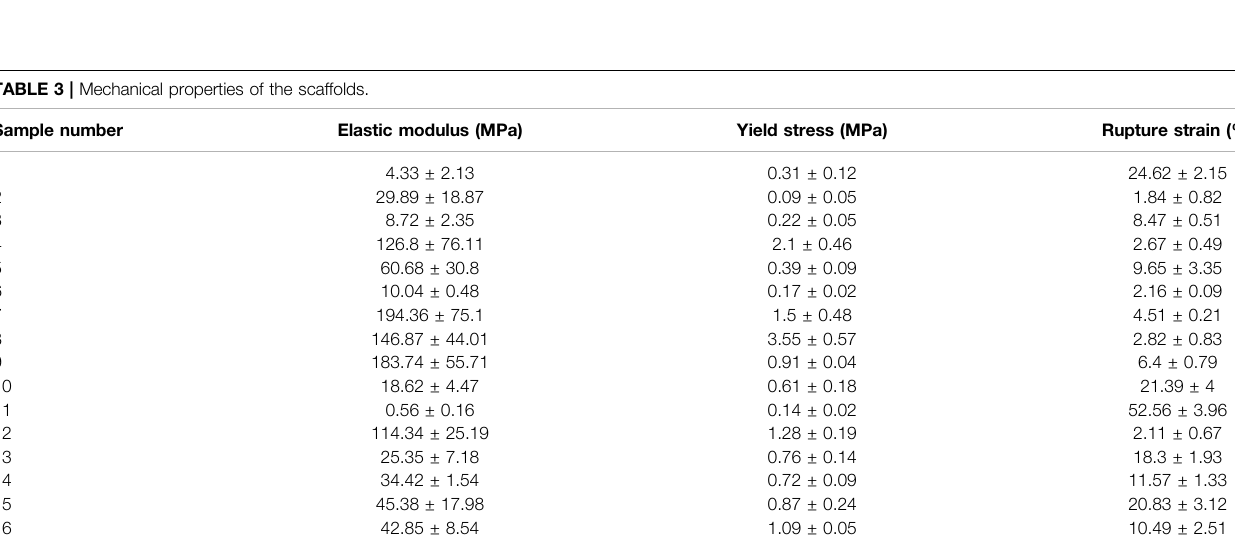
Frontiers in Bioengineering and Biotechnology |